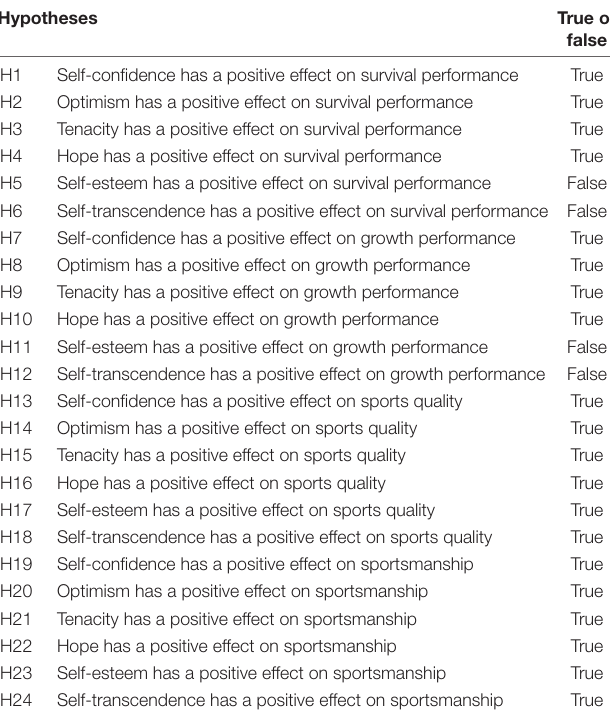
TABLE 13 | Verification on the hypothesis about PsyCap and sports